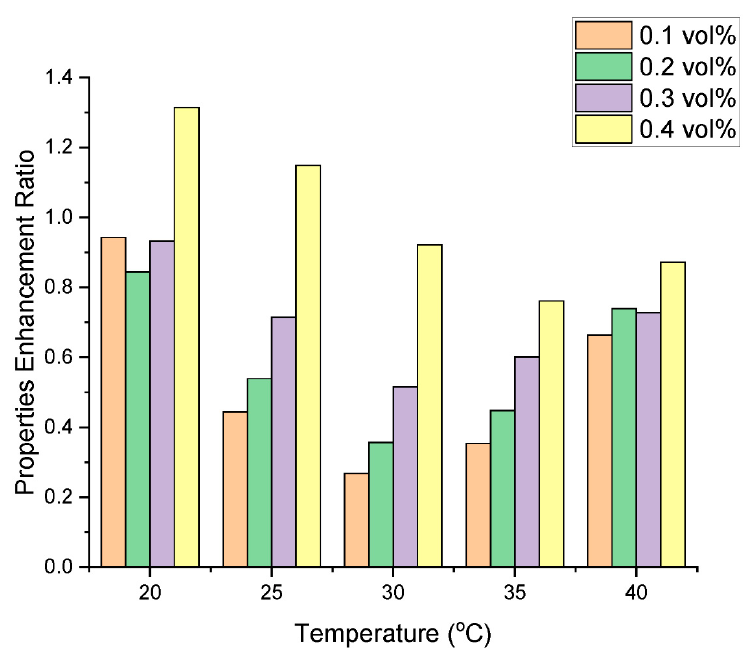
Figure 17. PER values of the hybrid nanofluid in relation to temperature and